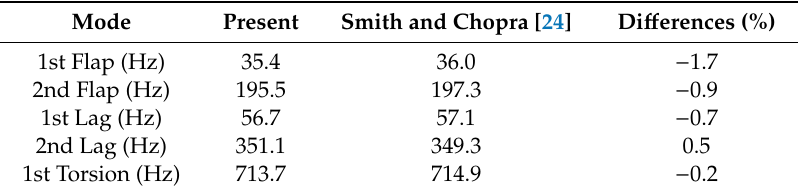
Table 1. The rotating frequencies of the composite rectangular box blade with symmetric layup ( Ω b = 1002 rpm).